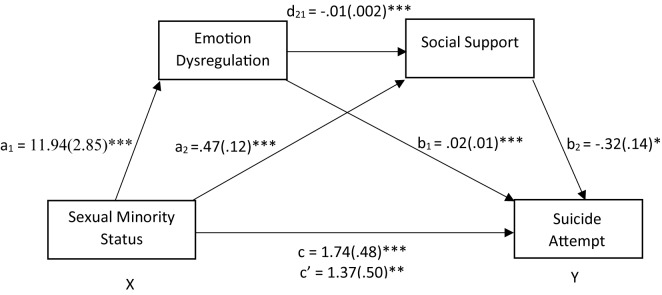
Emotion dysregulation and social support in sequence mediated the relationship between sexual minority status and suicide attempt. After adding the mediators, there is a significant indirect effect of sexual minority status on suicide attempt. The coefficients shown above are unstandardized. *Significant at the.05 level (2-tailed). **Significant at the.01 level (2-tailed). ***Significant at the.001 level (2-tailed).